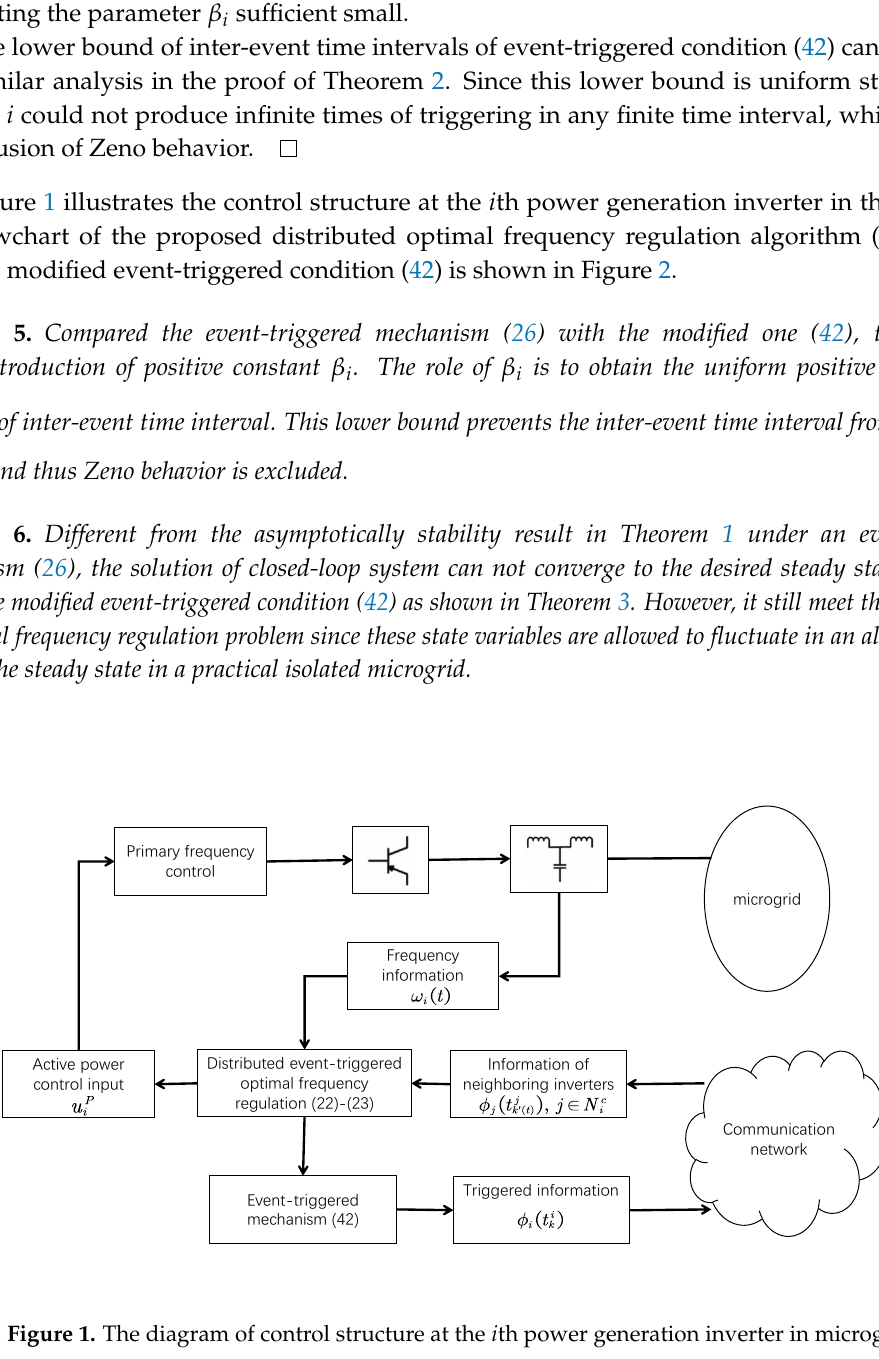
Figure 1. The diagram of control structure at the i th power generation inverter in